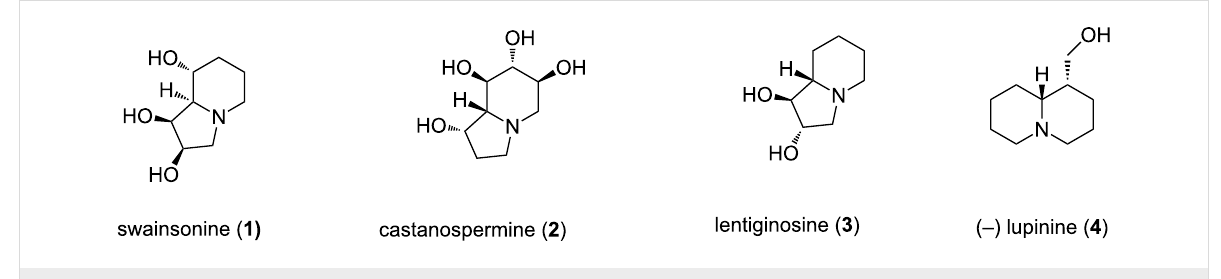
Figure 1: Selected polyhydroxyindolizidine and quinolizidines of